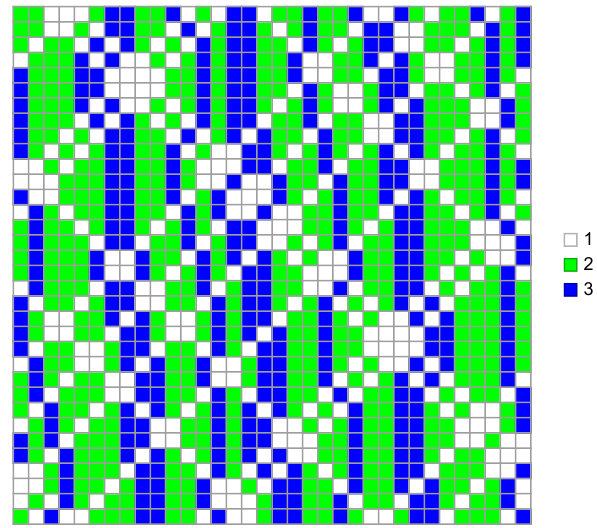
Figure 2: Example for time evolution in the XXC model of type 1 + 2. The initial state is a random configuration with equal weights for the 3